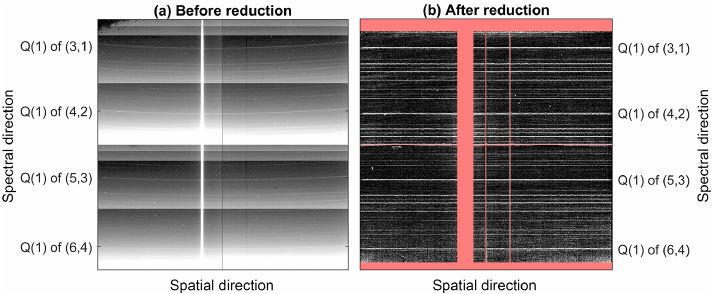
Figure 1. (a) The array in its raw form. The bright star is visible as a vertical band slightly to the left of centre. The curved OH lines are visible in the background. (b) The array after cleaning and flat fielding, with the star removed and the OH lines straightened. The unusable parts of the array are blanked out in red, and the OH lines can be seen clearly.